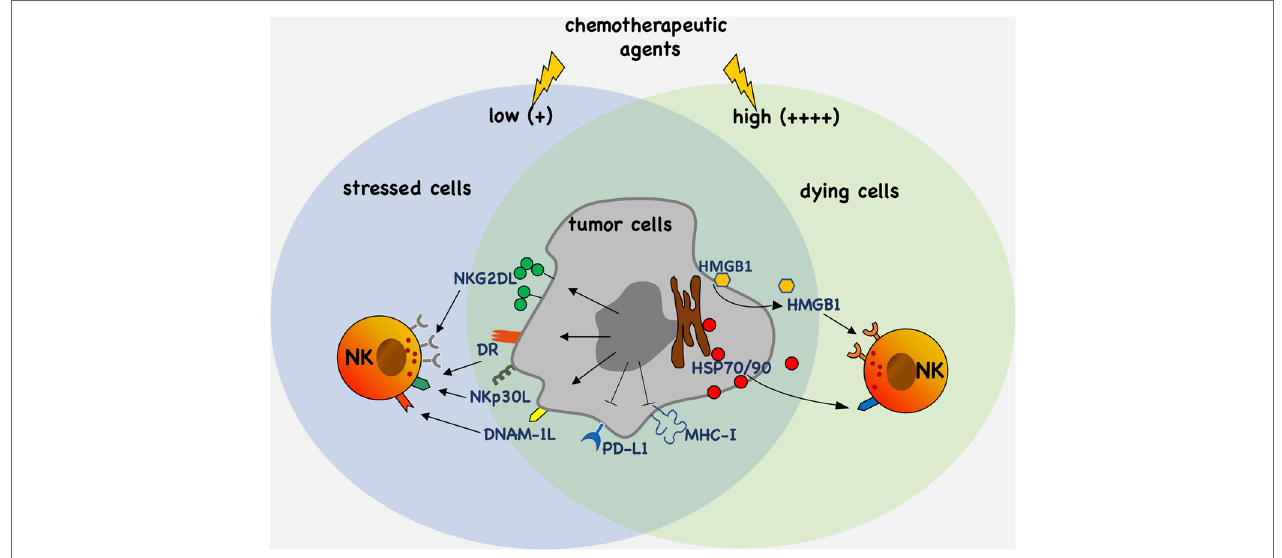
FiGURe 1 | Antitumor efficacy of chemotherapy. Chemotherapeutic agents activate molecular pathways eliciting upregulation and/or the release of stress molecules that promote tumor cell recognition and elimination by natural killer (NK) cells. Moreover, chemotherapy can also downregulate the expression of ligands such as PD-L1 and major histocompatibility complex (MHC)-I of inhibitory